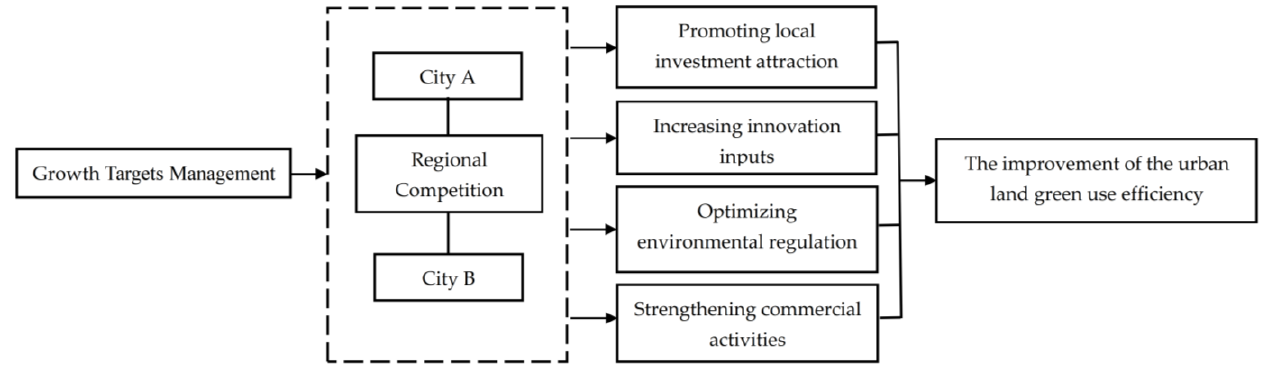
Figure 1. Analysis of the theoretical mechanism.